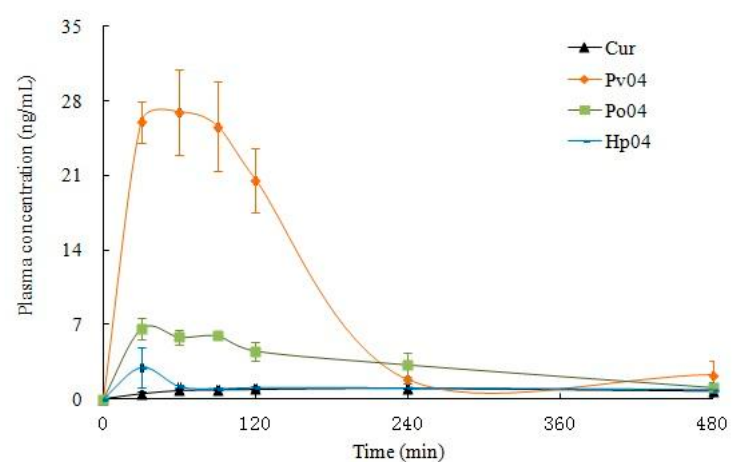
18 of 22 Figure 12. Snapshots of the HCD/Cur inclusion complex: ( A ) HCD/Cur initial structure system; ( B ) HCD/Cur structure after 50 ns MD; ( C ) initial structure in solvent system; and ( D ) system structure after 50 ns MD in the solvent system. 3.2. Oral Bioavailability In Vitro The retention time of Curcumin was 10 min with a good separation to plasma constituents (Figure 13). The standard Curve of Curcumin in plasma was linear over the concentration range of 0.1–50 μ g·mL − 1 examined. The regression equation for Curcumin was y = 32410x − 5179.0 (r = 0.9996), where y was peak area and x was the plasma concentration of Curcumin. The precision was measured